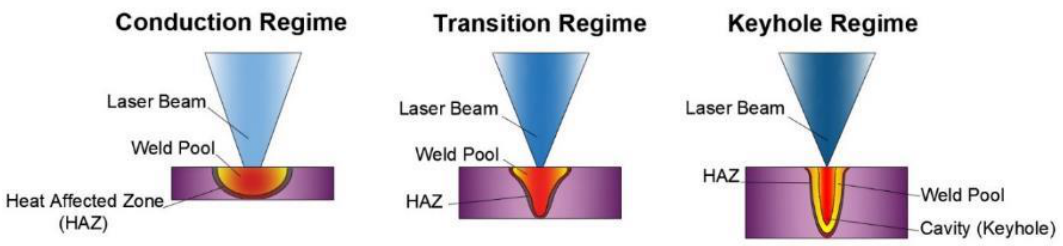
Figure 1. Different regimens of pulsed laser process. Adapted with permission from [36]. Copyright 2017 MDPI.